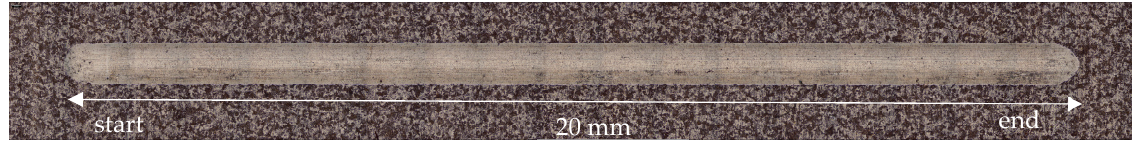
Figure 19. Example scratch from test 4, a steel sample.